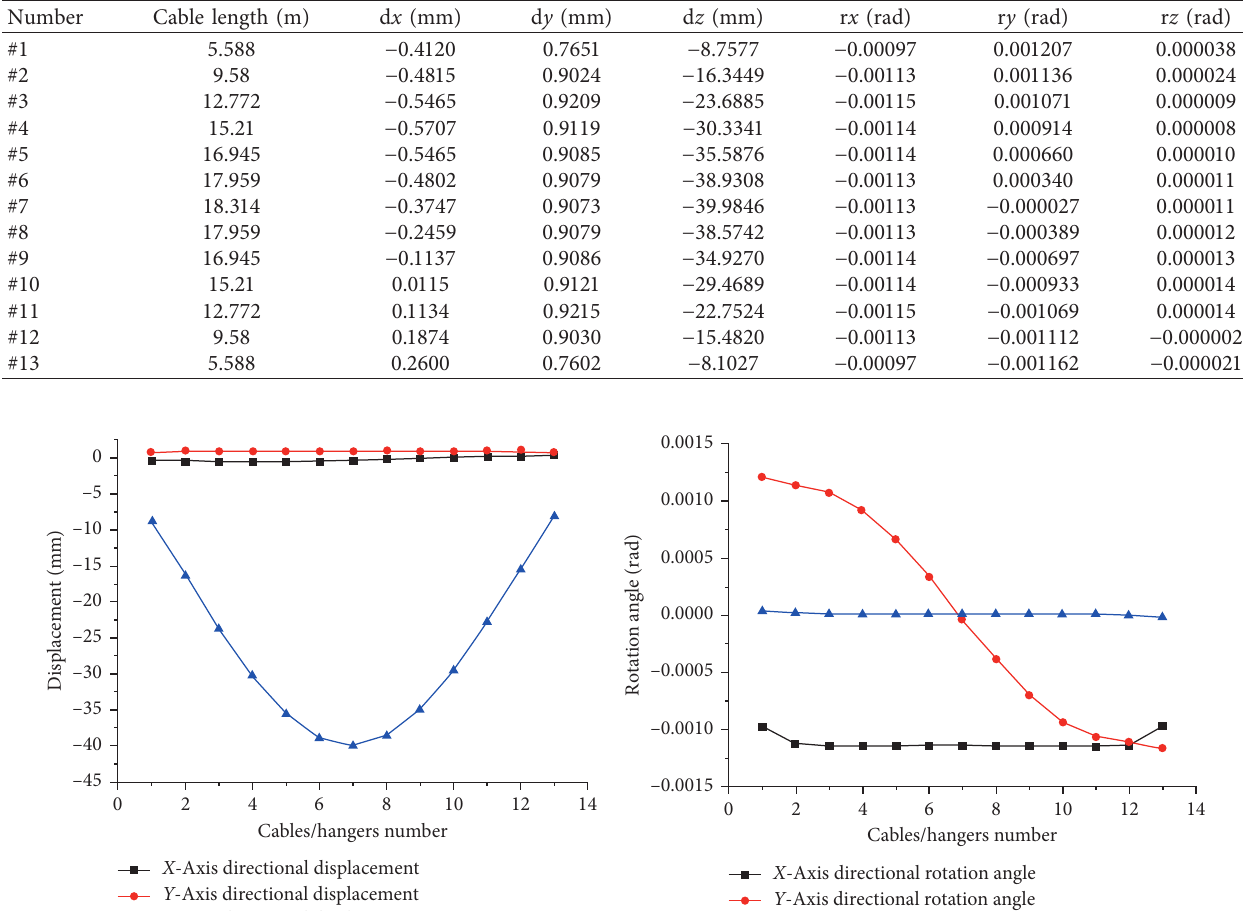
Table 1: Displacement and rotation of upper and lower cable/hanger anchorage areas under dead